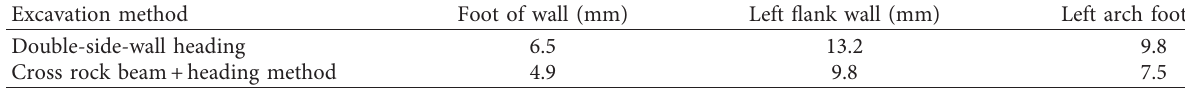
Table 3: Lateral displacement of the tunnel.